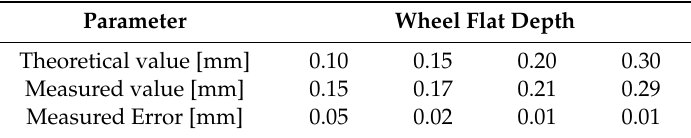
Figure 13. The measuring waveform of the simulated wheel flat. Table 1. Wheel flat measurement results. Table 1. Wheel flat measurement results.